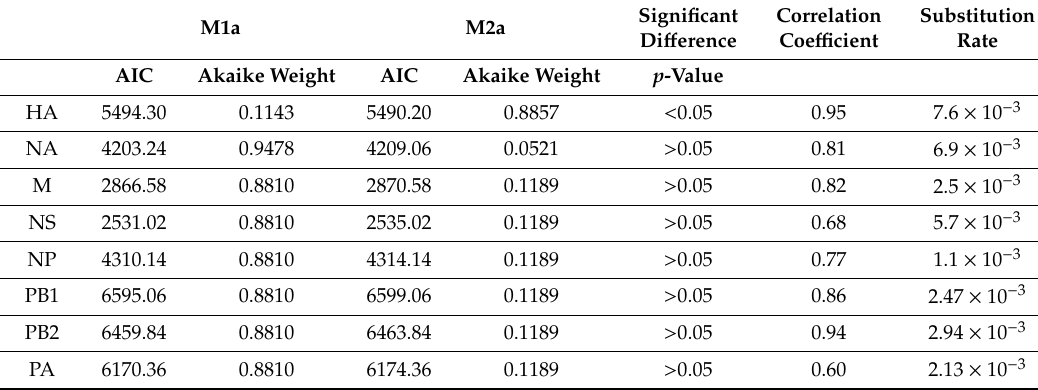
Table 3. The best fitting substitution model, temporal correlation coe ffi cient and nucleotide substitution rate of each gene